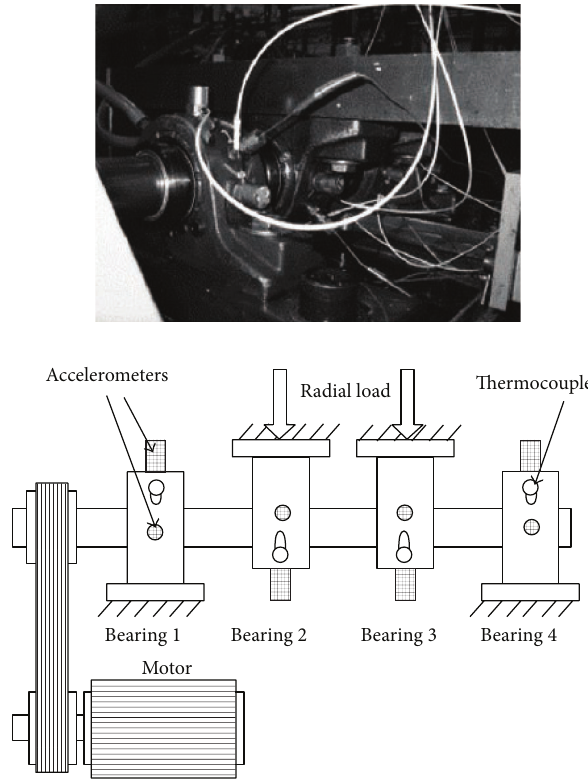
Figure 2: Bearing test tig and sensor placement illustration [29].